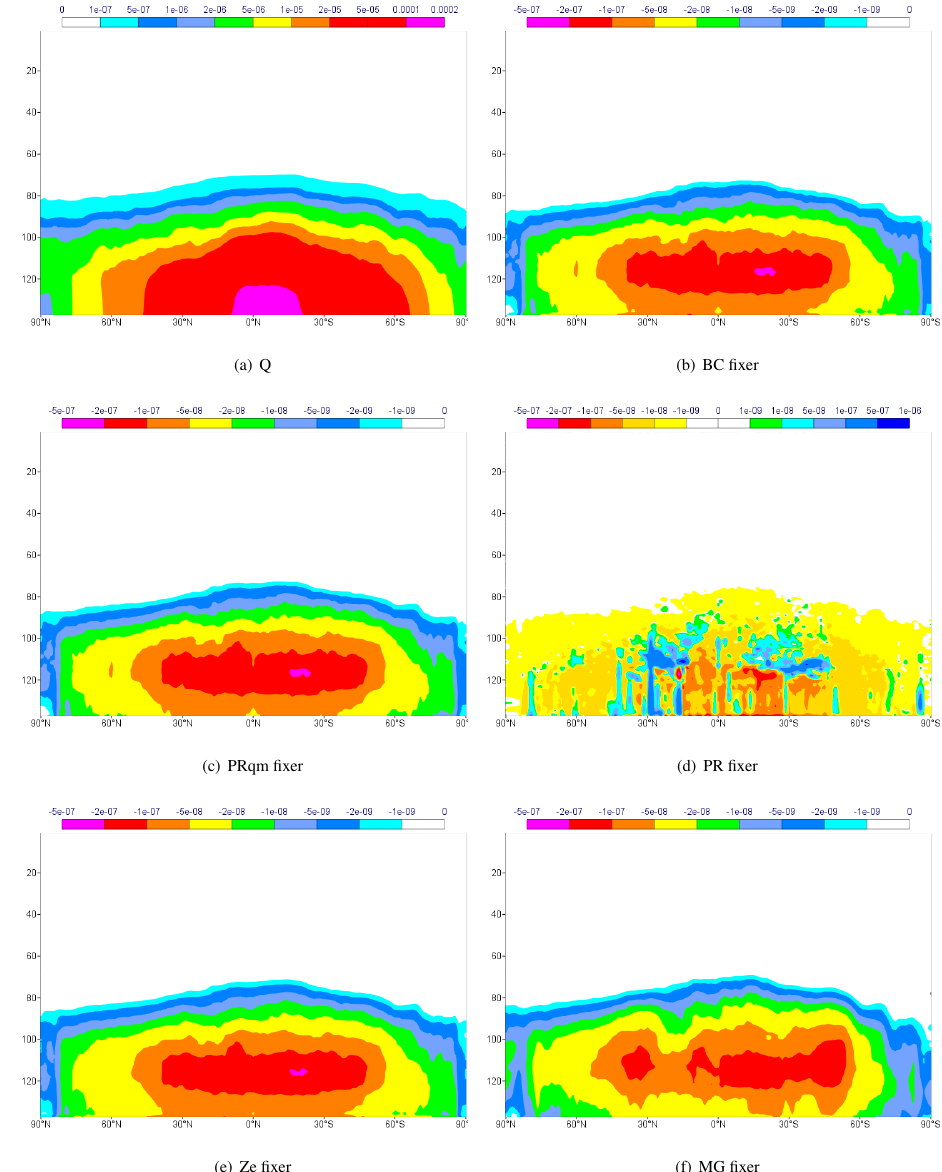
Fig. 4. Zonally-averaged and time-averaged (24 hrs) vertical cross sections for Q (plot a) and different MFA Figure 4. Zonally averaged and time-averaged (24h) vertical cross sections for Q (a) and different MFA increments (in kgkg − 1 ) for Q (b–f) . increments (in kg/kg) for Q (plots b-f). Vertical axis: model level number. Vertical axis: model level